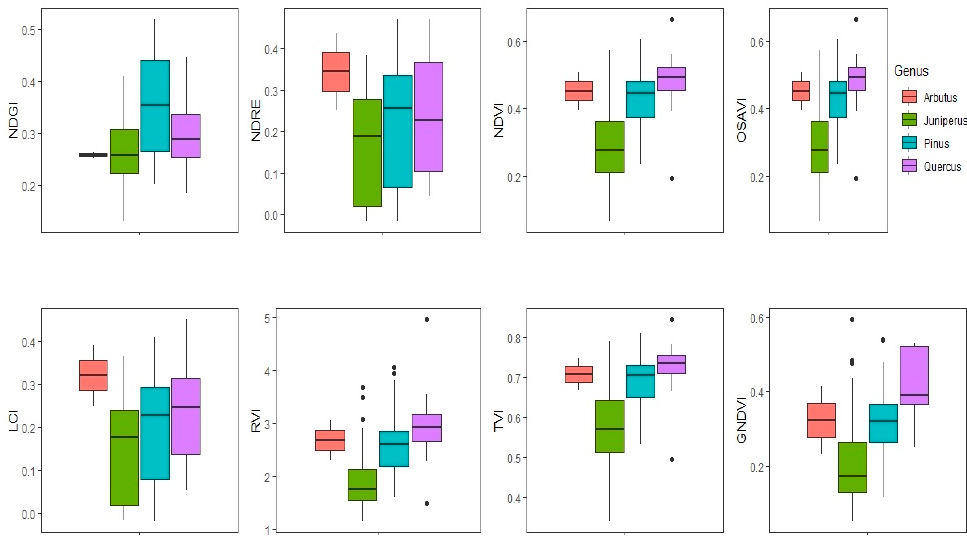
Figure 8. Distribution of the vegetation indices per genus in “El Cordoncito” in Mesa del Pawiranachi, NDVI = normalized difference vegetation index, GNDVI = green NDVI, LCI = leaf chlorophyll index, NDRE = normalized difference red edge index, OSAVI = optimized soil adjusted vegetation index, RVI = ratio vegetation index, TVI = transformed vegetation index, NDGI = normalized difference greenness index. Table 3. Statistical description of the maximum values of the vegetation indices of the de- tected